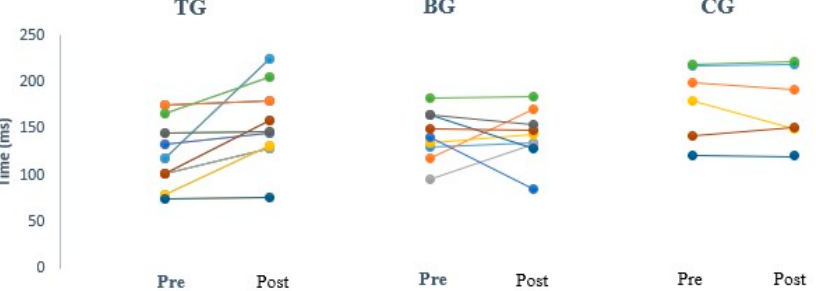
Figure 2. Change in cortical silent period in each participant pre and post intervention for the tackler (TG), ball carrier (BG) and control (CG) groups.